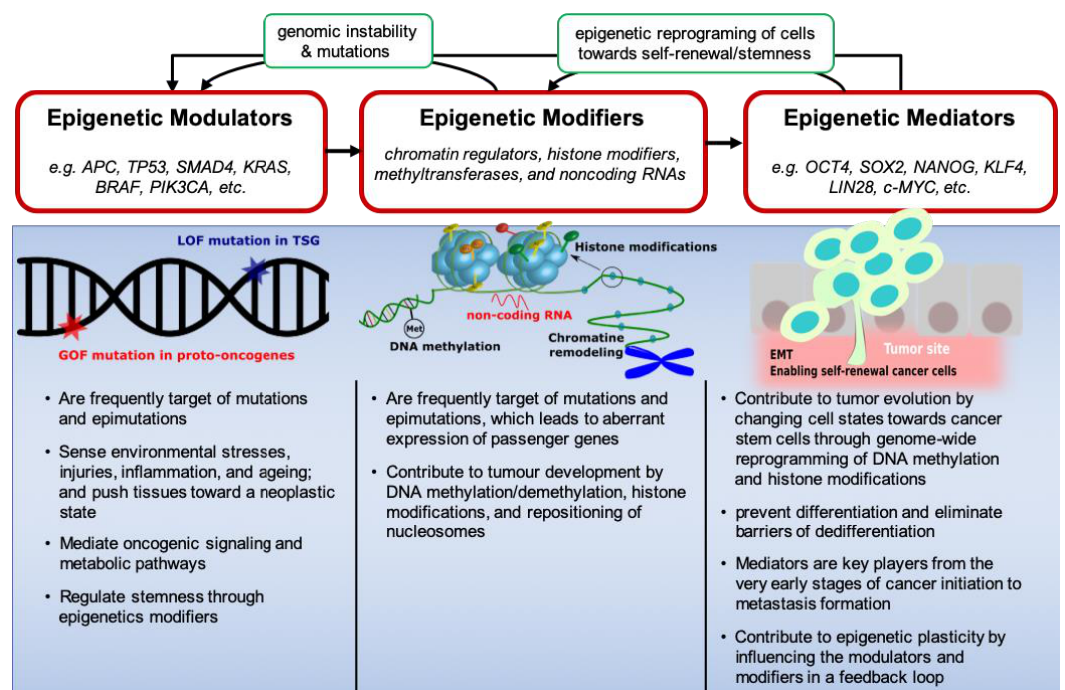
Figure 1. Epigenetic functional system in the initiation and progression of CRC. Environmental cues, such as repeated exposure to carcinogens, inflammation, injury, and ageing impinge on epigenetic modulators. These, in turn, destabilize the epigenome through signalling and metabolic pathways. As a result, chromatin states at epigenetic mediator genes are changed triggering their unscheduled expression. Epigenetic mediators can also influence the plasticity of tumour cells during neoplasia, giving rise to the formation of CSCs and metastases. In all these processes, epigenetic modifiers play a central role. Mutations are frequently seen in epigenome modifying genes and, conversely, the epigenetic changes can cause further mutations and genomic instability in modulators. LOF = loss of function; TSG = tumour suppressor gene; GOF = gene of interest; Met = methylation; EMT = epithelial to mesenchymal transition.